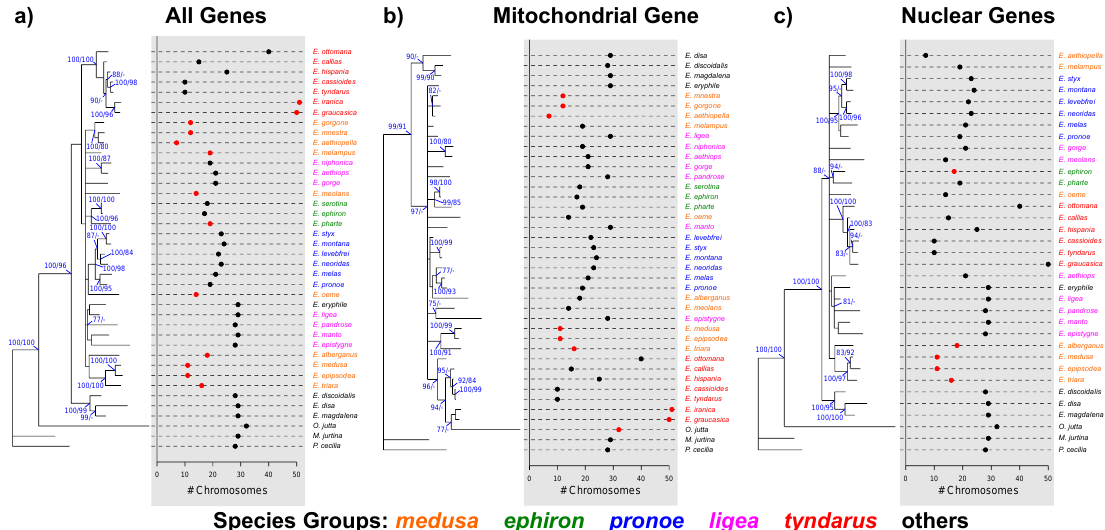
Figure 2. Majority rule consensus phylograms, each based on 1000 post burn-in trees using either ( a ) all four genes combined ( n = 40 taxa), ( b ) the mitochondrial COI gene ( n = 40 taxa), and ( c ) sequences of three nuclear genes (glyceraldehyde-3-phosphate dehydrogenase ( GAPDH) , ribosomal protein S5 ( RpS5) , wingless ( WG) ) combined ( n = 35 taxa). Numbers at each node indicate the posterior Bayesian probabilities followed by the bootstrap support for maximum likelihood trees. Only support values ≥ 75% are indicated. The haploid chromosome number is indicated for each species. Red dots highlight cases with a significant local Moran’s I based on 1000 permutations. Species label colors designate different Erebia groups (see also Figure 1).